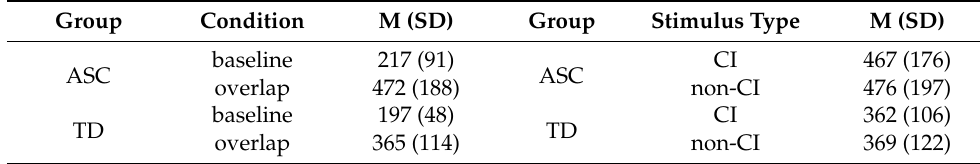
Table 6. The means and standard deviation of saccade reaction time (ms) in Experiment 3.